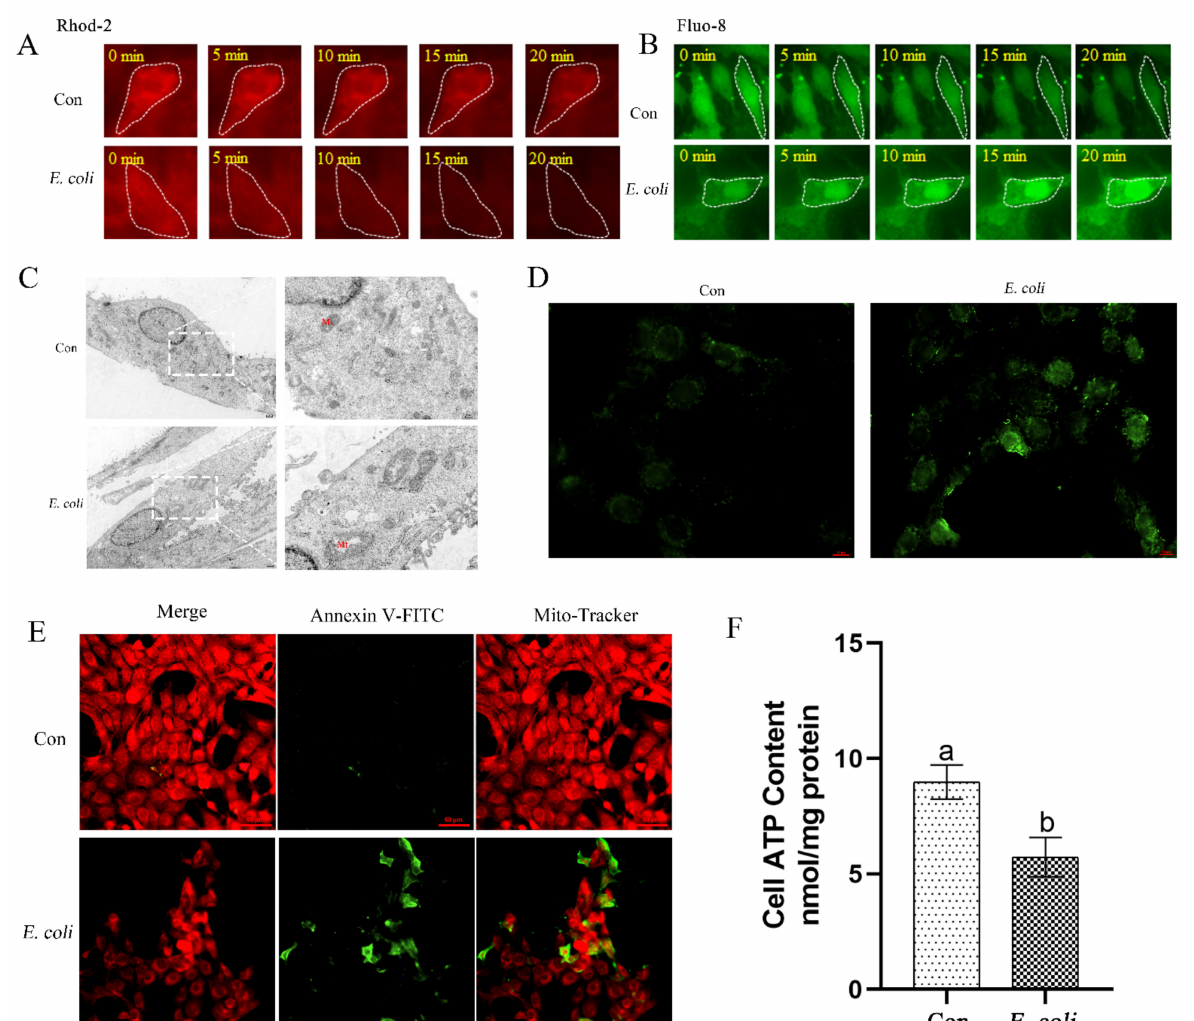
Figure 2. Effects of E. coli on calcium mobilization and mitochondrial function in bEECs. Primary bEECs were either uninfected or infected with E. coli and cytoplasmic Ca 2+ levels and cellular mitochondria function was measured. ( A ) Mitochondrial Ca 2+ reporter Rhod-2 was used for real- time cellular imaging to measure mitochondrial Ca 2+ levels. The cells were infected with or without E. coli for up to 20 min. ( B ) Fluo-8 AM was used to monitor cytosolic Ca 2+ levels in real time. Cells were exposed or not exposed to E. coli for up to 20 min. ( C ) The mitochondria in bEECs were analyzed by transmission electron microscopy after infection with E. coli for 6 h. ( D ) ROS was measured after infection with E. coli for 6 h. Scale bars = 10 µ m. ( E ) Cells were infected with E. coli for 6 h, and membrane potential was detected by Mito-Tracker Red CMXRos. Scale bars = 50 µ m. ( F ) The ATP concentration was detected using an ATP assay kit after infection for 6 h. Con, no infection control; Mt, mitochondria. The data are means ± SEM of three independent experiments. Bars with different letters indicate significant differences ( p <